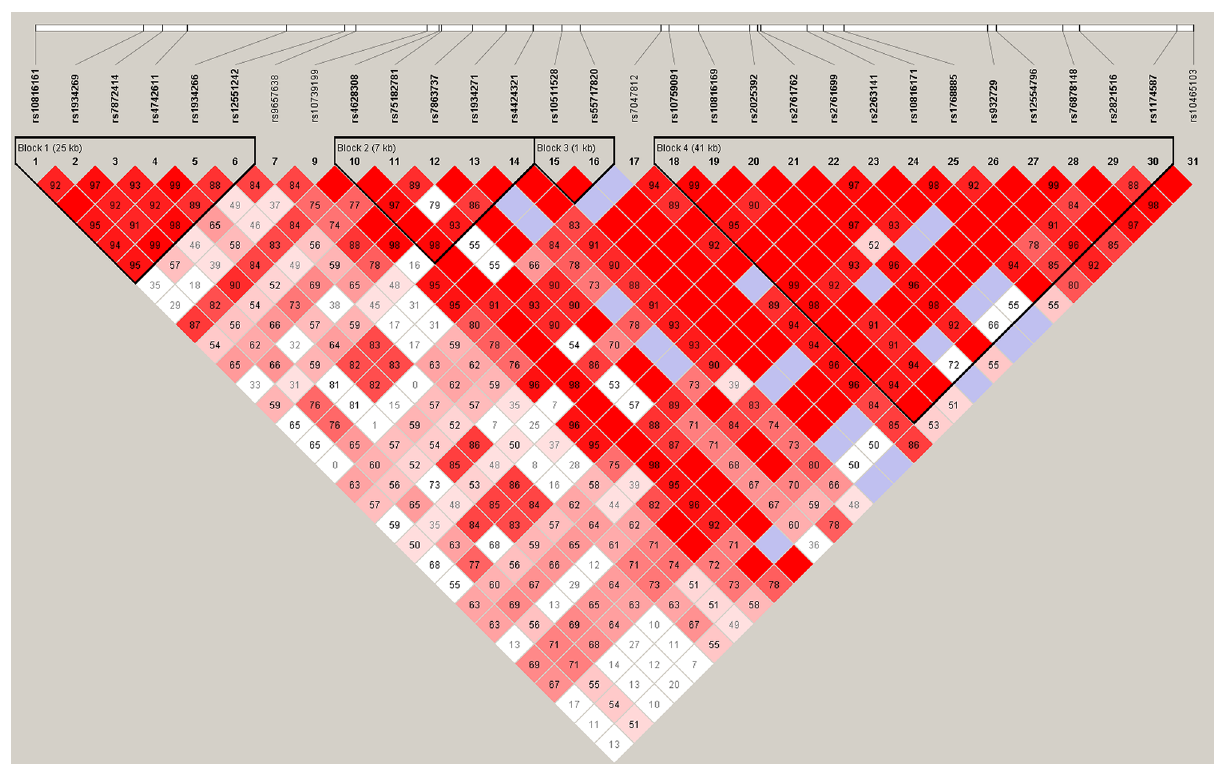
Figure 3. Linkage disequilibrium (LD) plot for the 31 PTPRD SNPs analyzed. The values in boxes are pair-wise SNP correlations (D ′ ); bright red boxes without numbers indicate complete LD (D ′ = 1). The texts above the horizontal numbers are the SNP names, and the blocks indicate haplotype blocks.